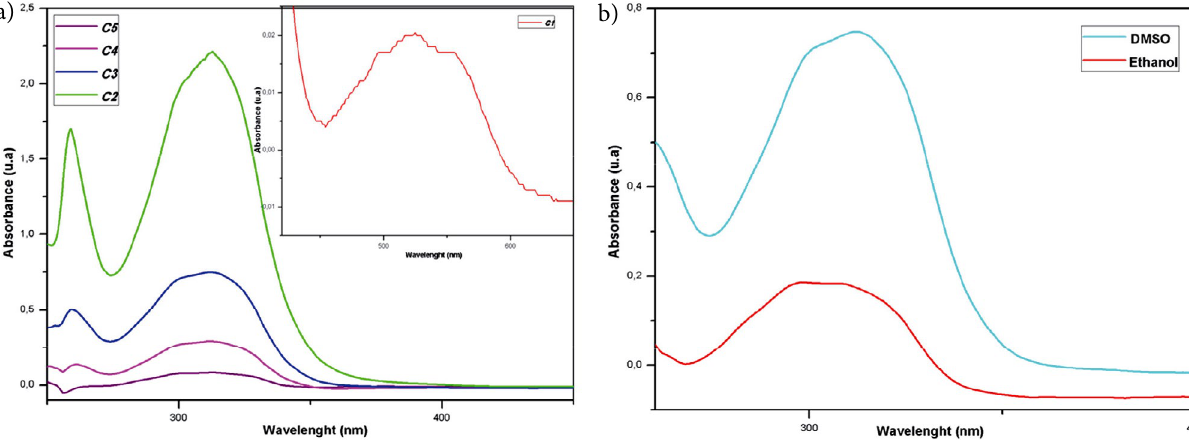
Figure 2. (a) Absorption spectra of complex recorded in DMSO at different concentrations c 2 = 0.7 ∙ 10 –4 M, c 3 = 1.6 ∙ 10 –5 M, c 4 = 0.26 ∙ 10 –5 M and c 5 = 0.4 ∙ 10 –6 M. The inset shows the spectrum at c 1 = 0.6 ∙ 10 –3 M. (b) UV-Visible spectra of complex Co(II) at different solvents (EtOH and DMSO) at 1.6 ∙ 10 –5 M concentration.